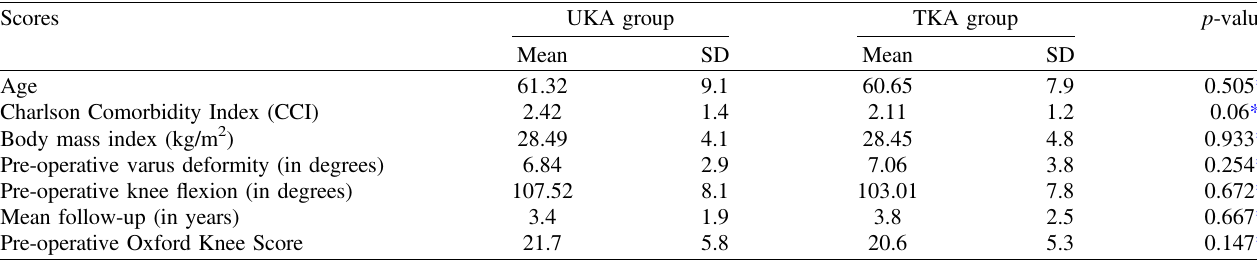
Table 1. Baseline characteristics of the study